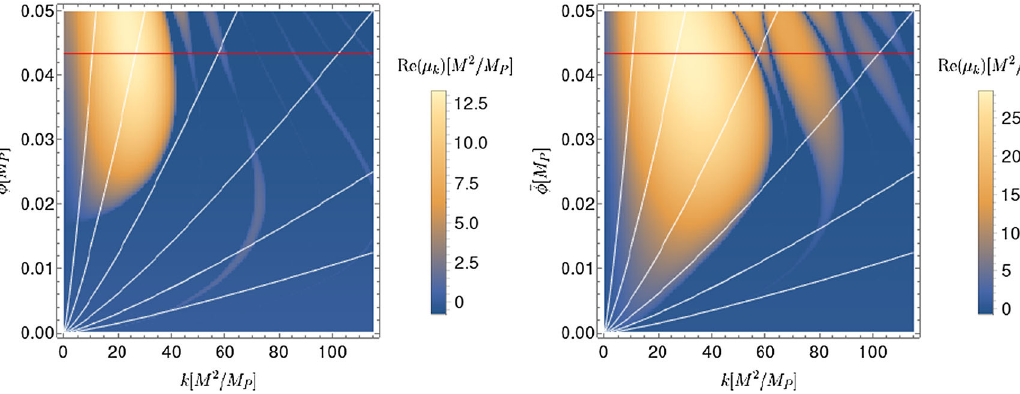
Fig. 5 Floquet exponents for the inflaton (left panel) and the spectator (right panel) perturbations with n = 3 / 2 and α = 10 −